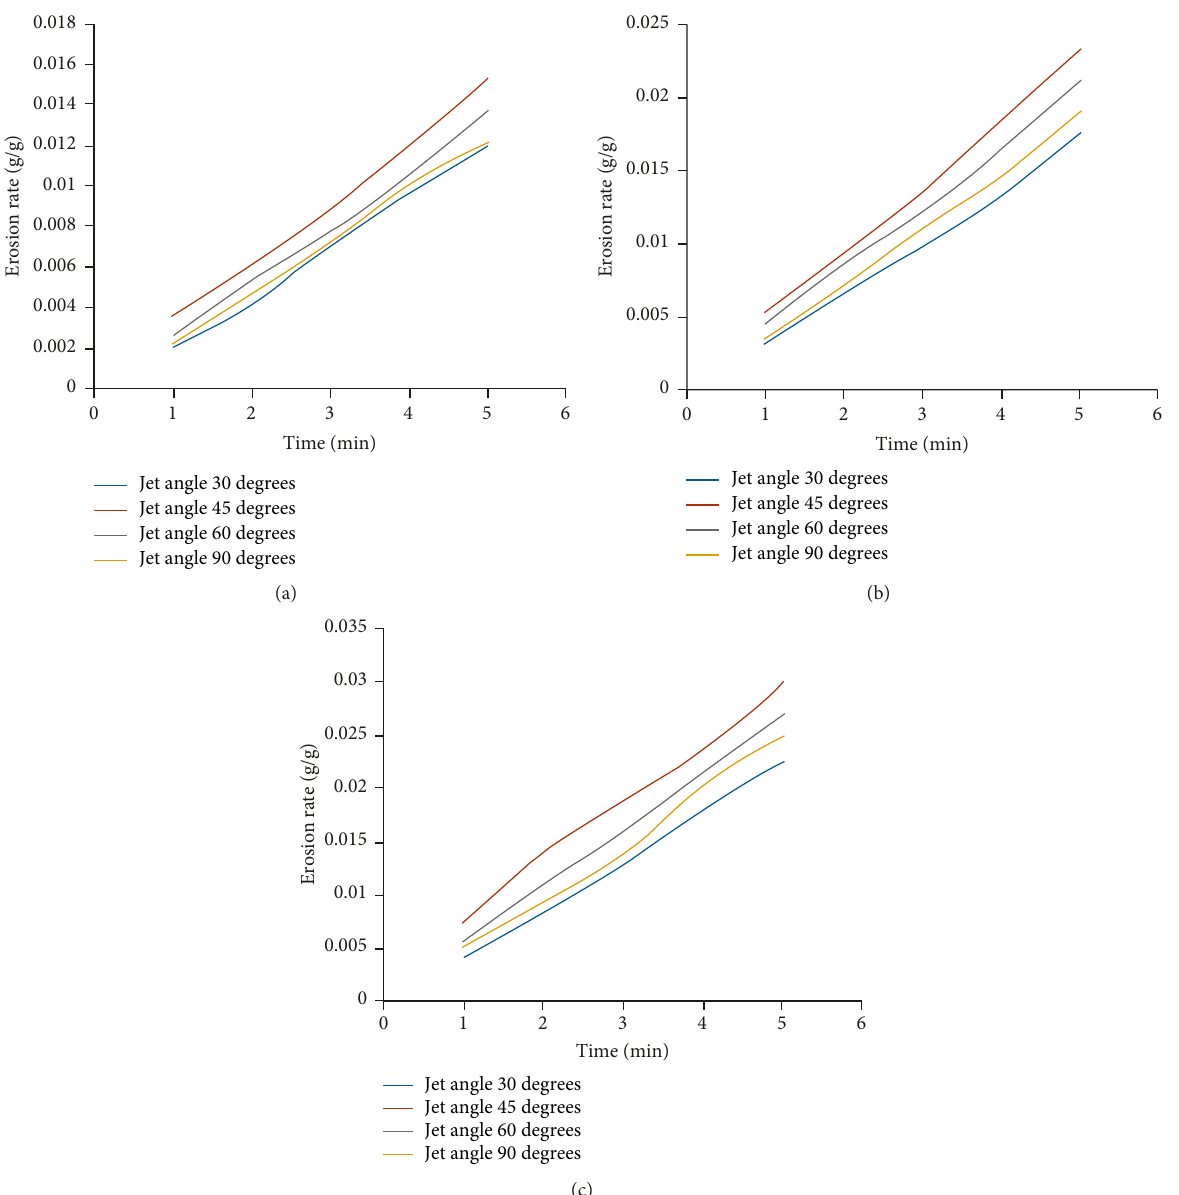
Figure 5: 5 layers glass fibre. (a) 1 bar pressure and 7.5% micro carbon powder filler. (b) 1.5 bar pressure and 7.5% micro carbon powder filler. (c) 2 bar pressure and 7.5% micro carbon powder